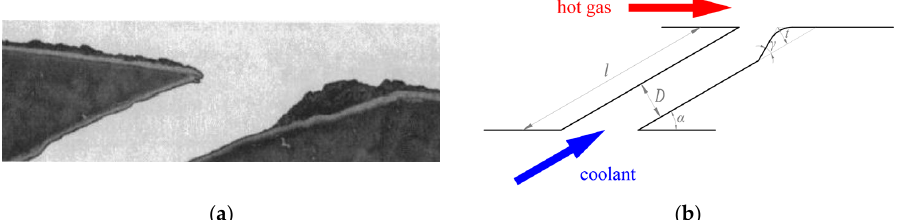
Figure 5. Blockage of film cooling hole exit. ( a ) Photo of blockage [5]; ( b ) schematic diagram of blockage.